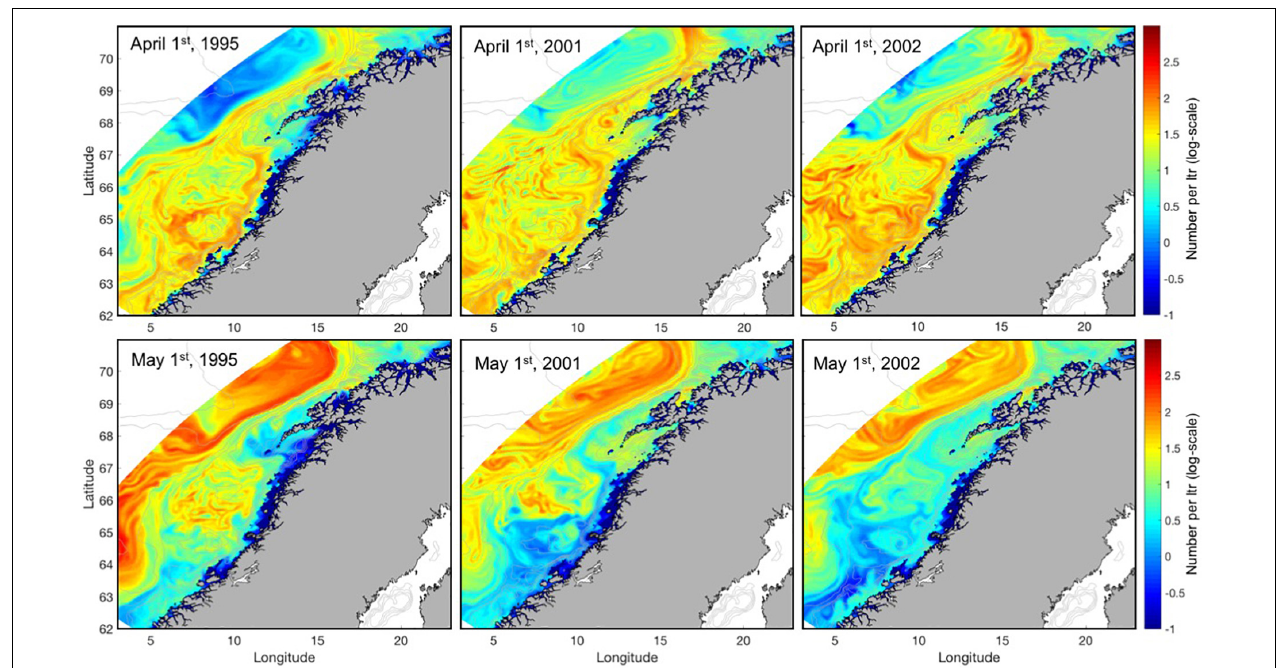
FIGURE 3 | The logarithmic sum of C. finmarchicus nauplii abundance per liter for stages 3 and 4 when distributed homogeneously across a 10 m water column at April 1st (upper panels) and May 1st (lower panels) for 1995, 2001, and 2002 (left to